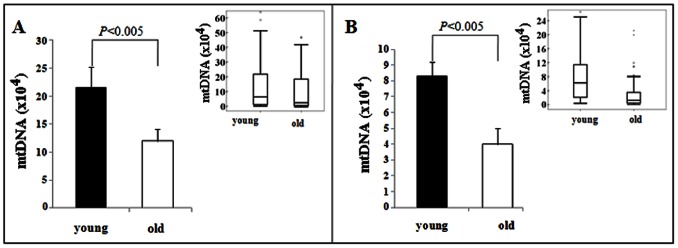
Real-time PCR analysis of mtDNA copy numbers in individual mouse (A) and hamster (B) oocytes.mtDNA copy numbers were significantly lower in old oocytes compared to young oocytes in both mice and hamsters. There is a 44% decrease in mtDNA number in aged mouse oocytes and a 51.8% decrease in aged hamster oocytes. Data were also presented as median with 10th, 25th, 75th, and 90th percentiles and outliers shown in whisker plot inserts.